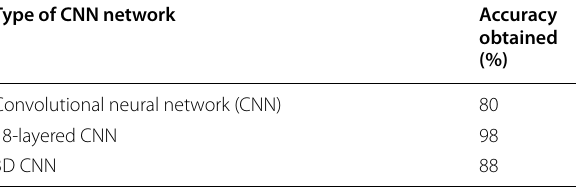
Table 5 Accuracies obtained for different